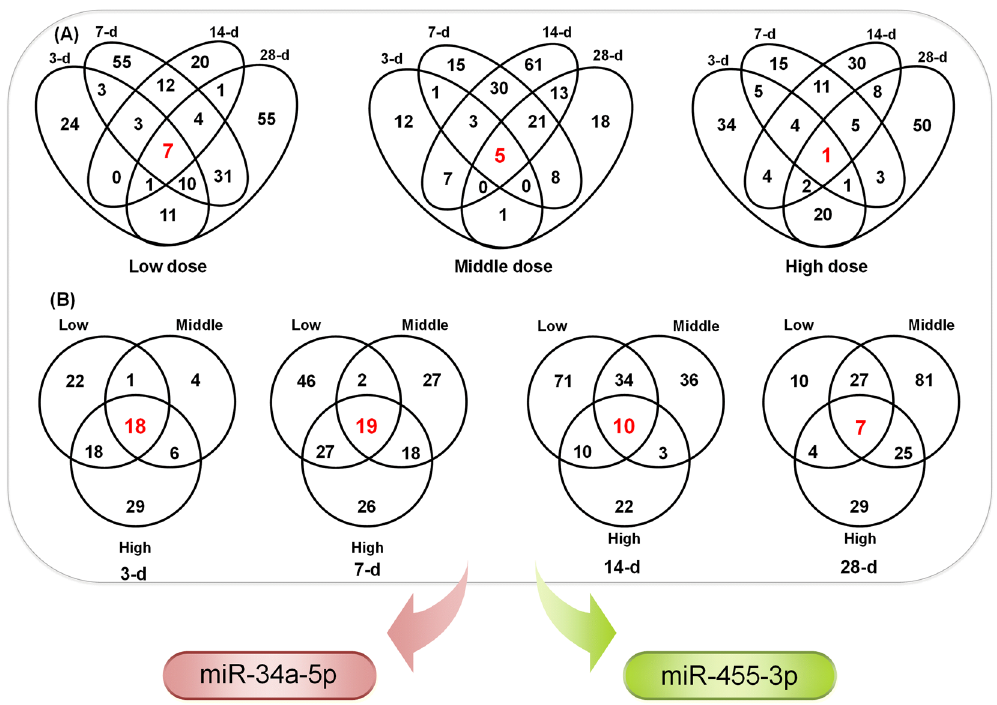
Figure 5. Venn diagrams of DEMs during different time points and doses. ( A ) depicts DEMs during low, middle and high doses with different time points, respectively and ( B ) describes DEMs during 3-, 7-, 14- and 28-d with three different doses (low, middle and high). Two potential biomarkers (miR-34a-5p and miR- 455-3p) out of 48 overlapping DEMs are found common across all the